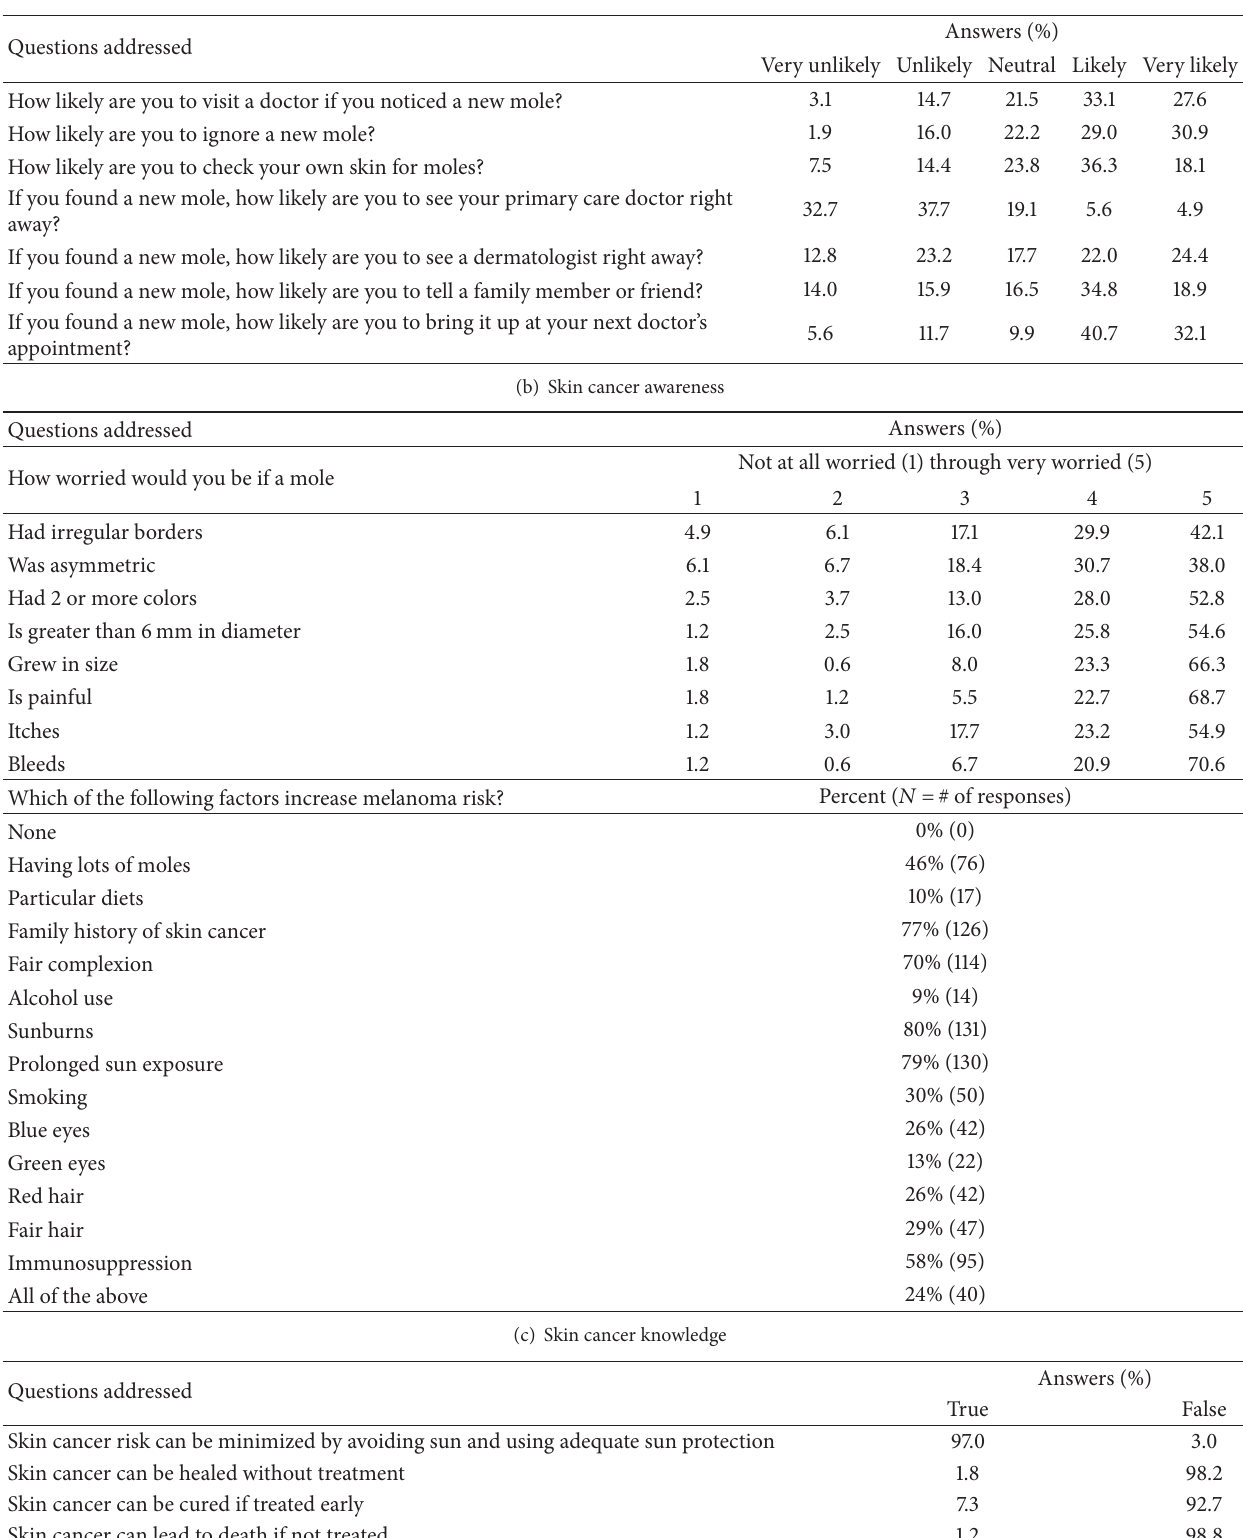
Table 1: Categorized questions and answers for skin cancer variables (skin cancer prevention, awareness, knowledge, skin protection, and sun